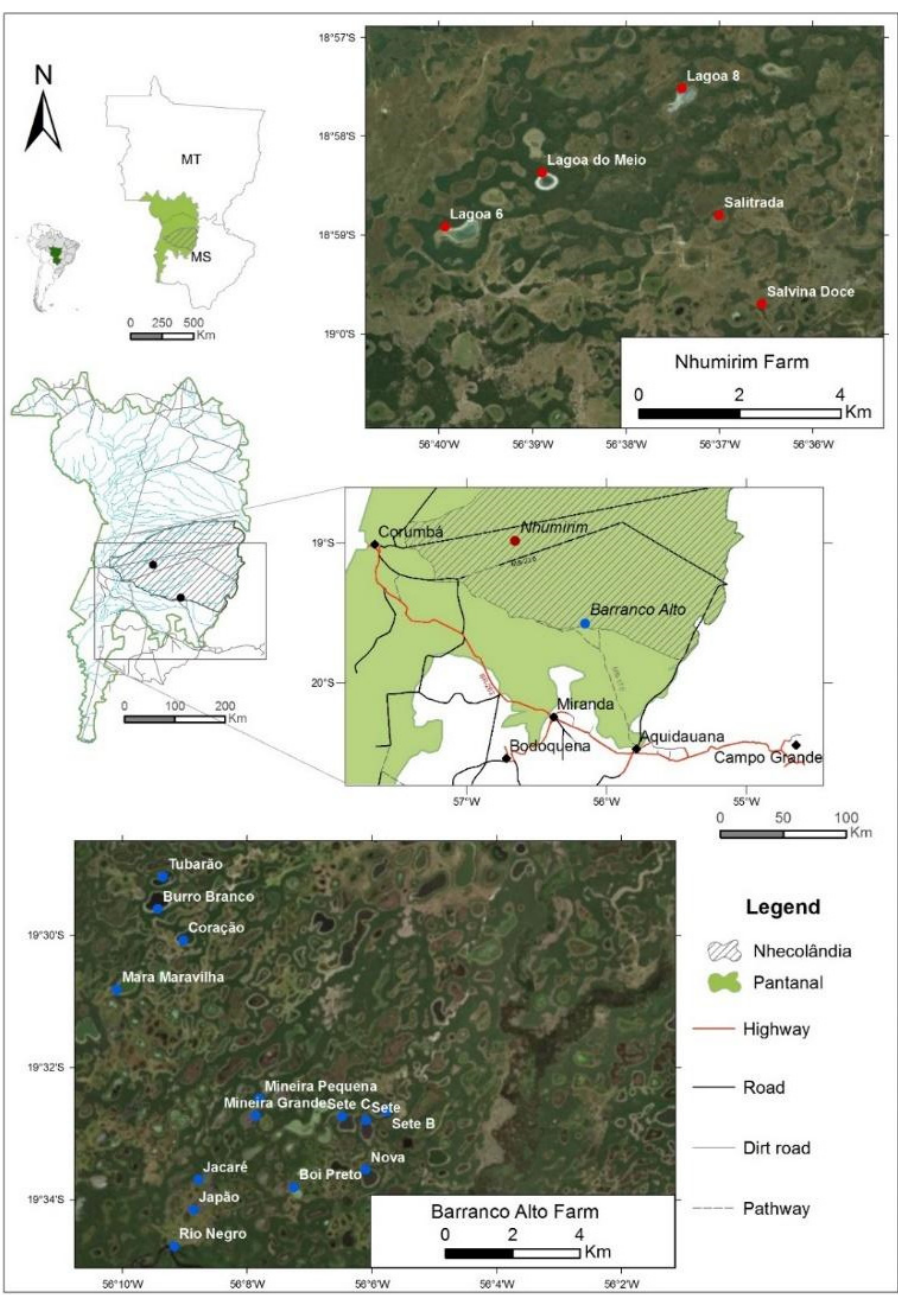
Figure 1. Map of the Barranco Alto and Nhumirim farms in the sub-region of Nhecolândia , Pantanal wetland (Brazil).